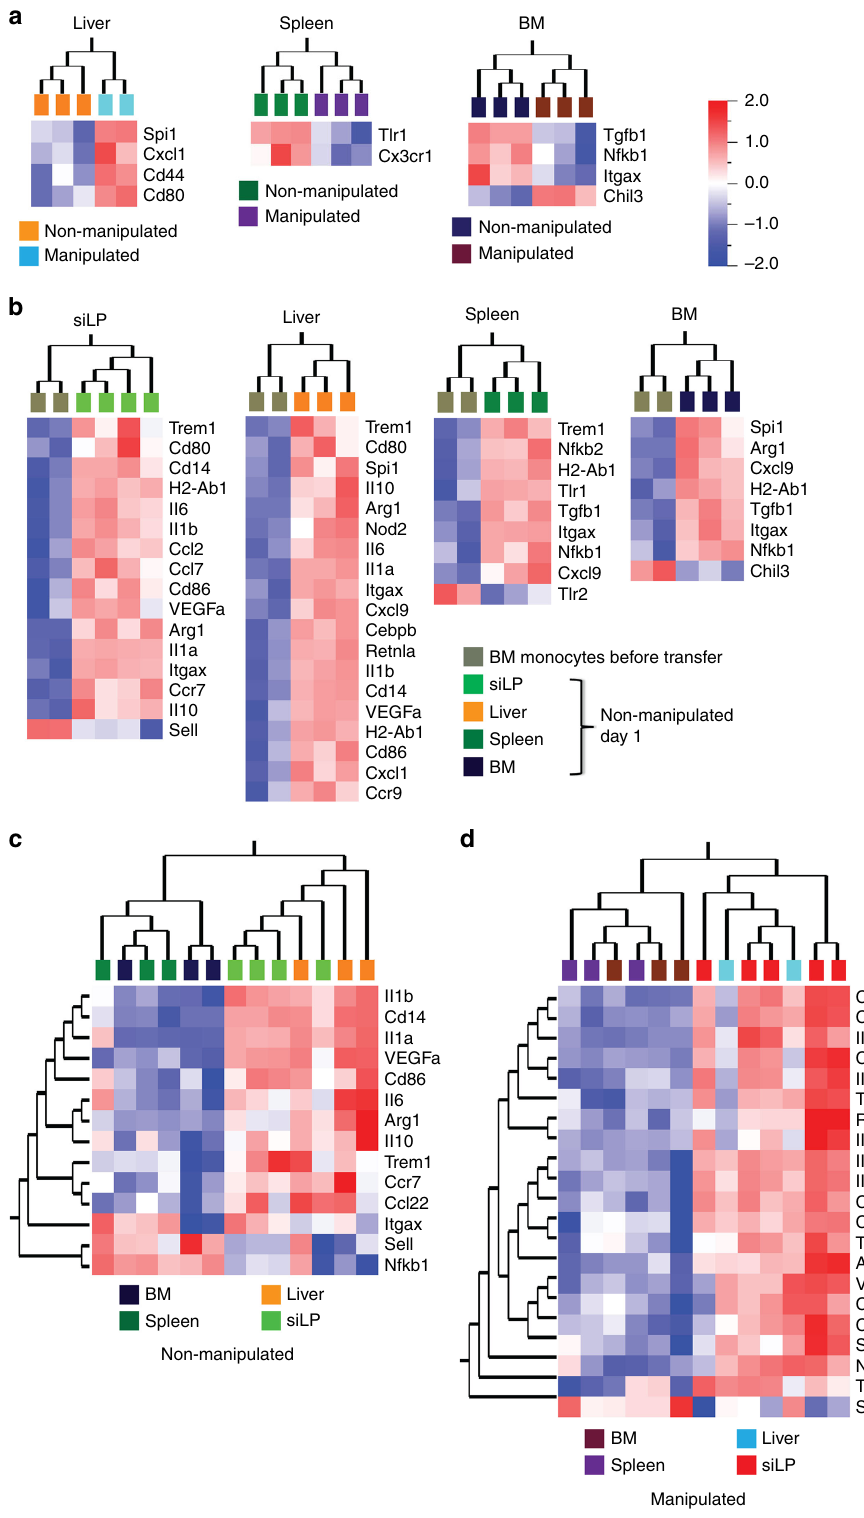
Fig. 6 Tissue-speci fi c signals instruct local monocyte adaptation. a Heat map showing gene expression pro fi les of donor monocytes recovered one day after transfer from liver, spleen, and BM comparing non-manipulated and manipulated recipients. b Gene expression pro fi les comparing donor BM monocytes before transfer with donor monocytes recovered from small intestine, liver, spleen, or BM of non-manipulated recipient at day 1 after transfer. c , d Comparison of gene expression pro fi le of donor monocytes recovered at day 1 after transfer between small intestine, liver, spleen and BM of non- manipulated ( c ) and manipulated ( d ) recipients. Transcriptomic analysis was performed using nanostring nCounter analysis and differentially expressed genes were determined by Qlucore Omics explorer with a statistical signi fi cance p -value of 0.05. Data were pooled from 2 – 3 independent experiments with a total of 2 – 4 mice as indicated in each section of the fi